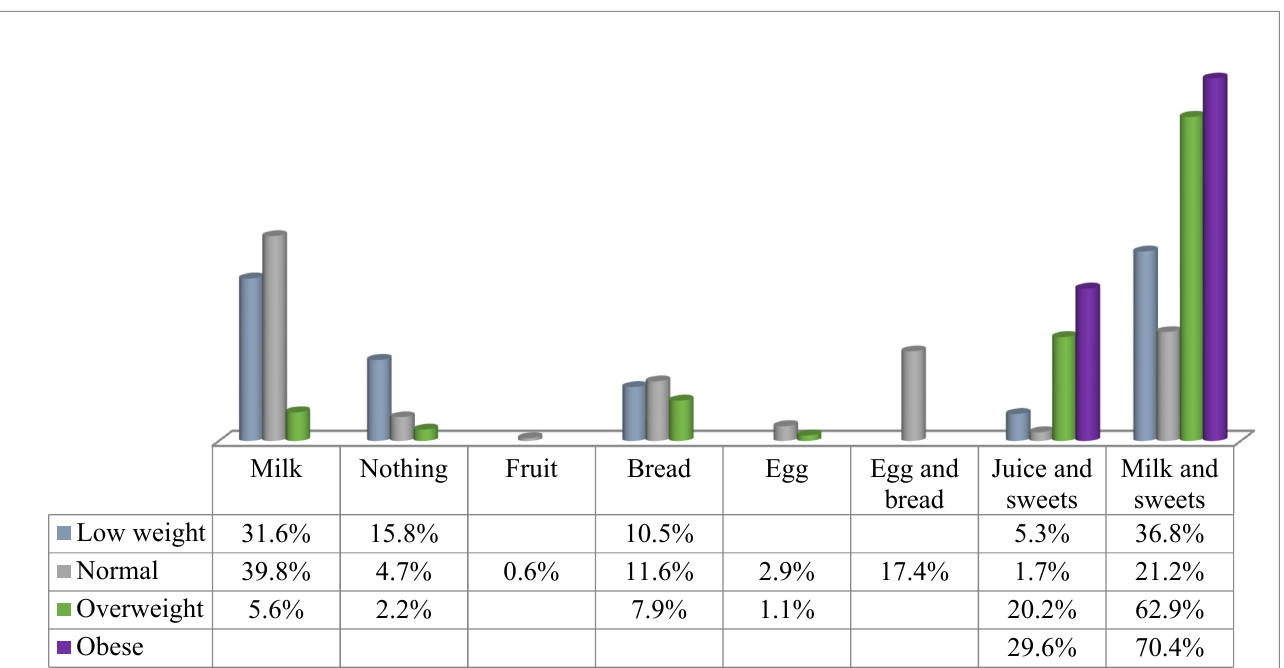
Figure 3. Food consumption at breakfast according to the BMI prior to the intervention.